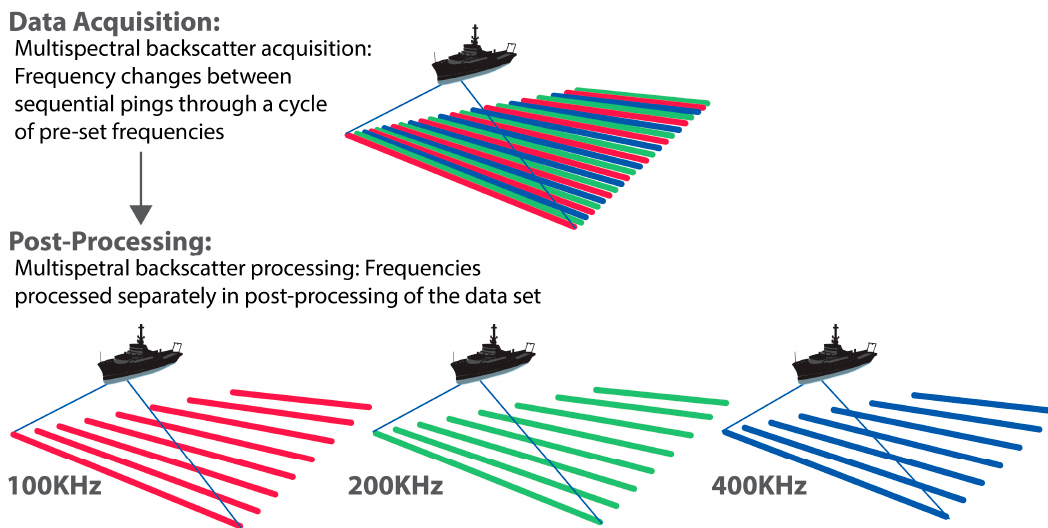
Figure 3. Data acquisition and post-processing of multispectral backscatter data.